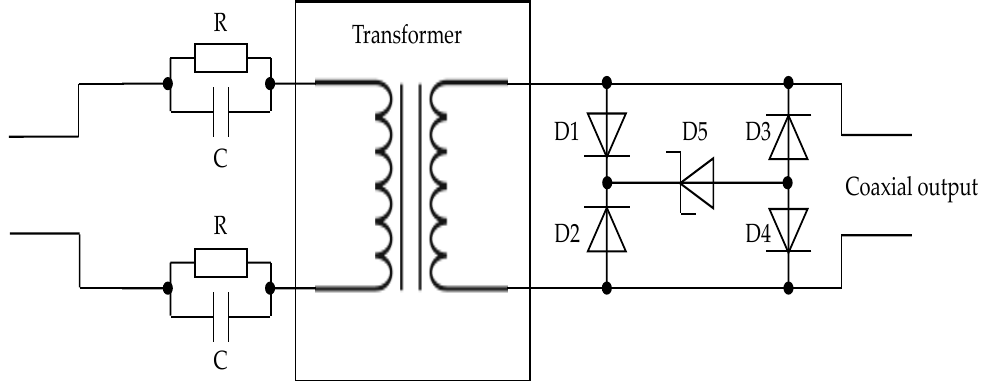
Figure 5. Electrical schematic of the NB-PLC capacitive coupler.